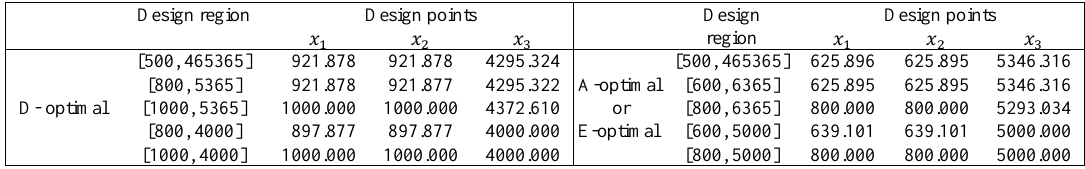
Table 14. D-, A- and E-optimal designs for generalized Pareto model with three support points